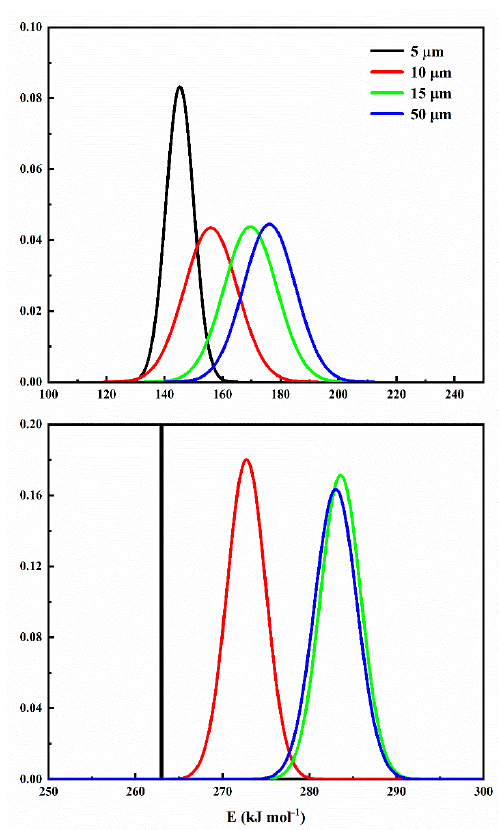
Figure 7. Activation energy distribution in distributed activation energy distribution method with Gaussian distribution for four particle sizes. Polymers 2020 , 12 , 421